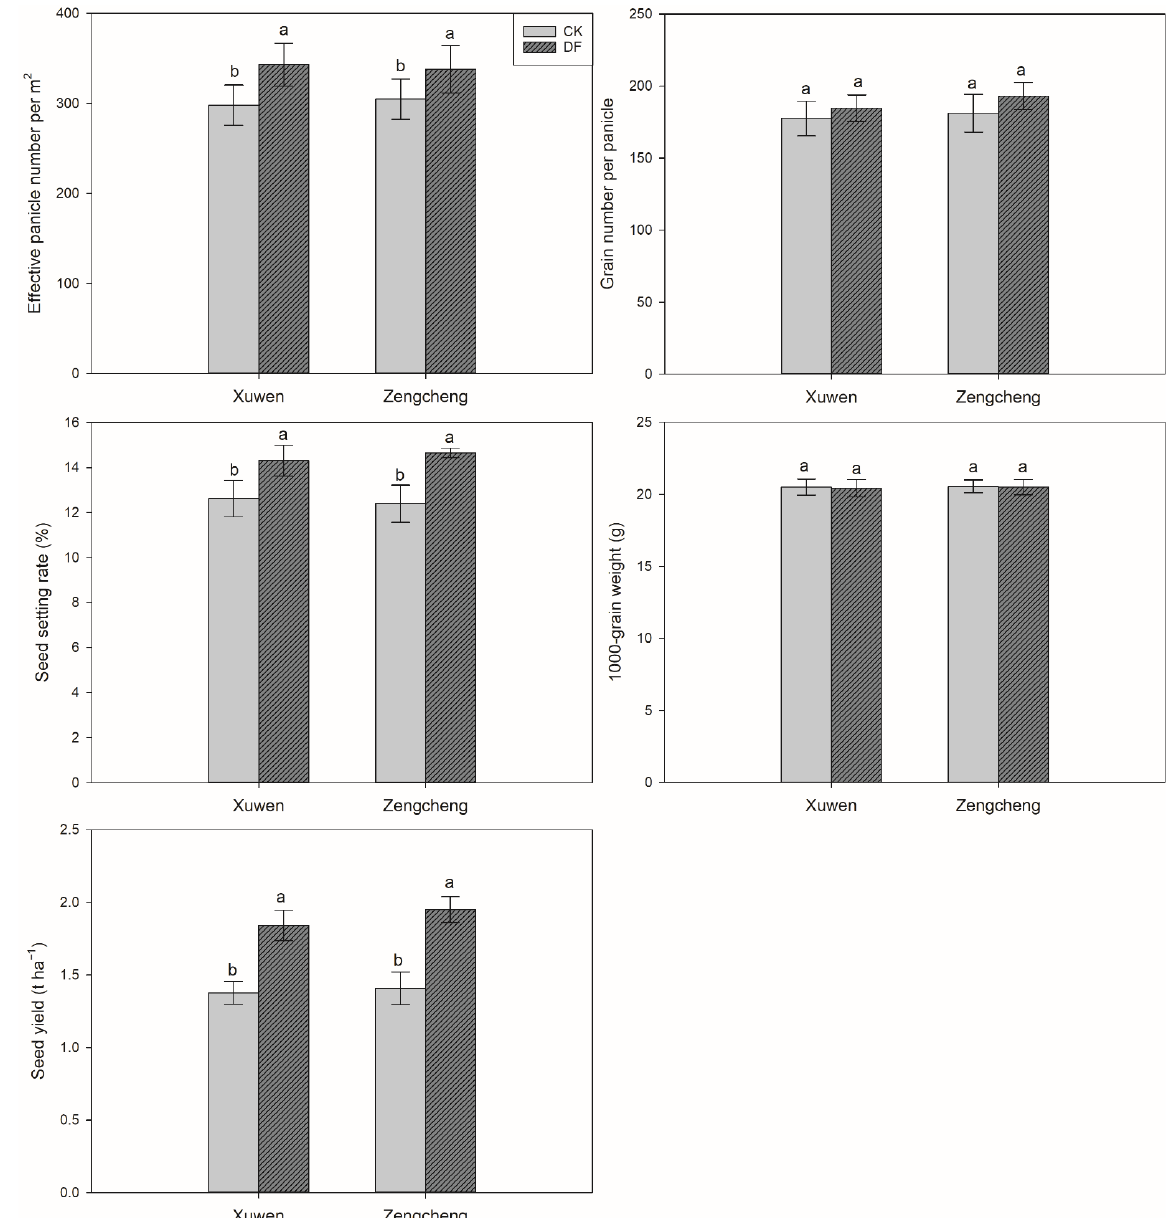
Figure 2. Effects of different fertilizer application methods on hybrid rice seed production. CK: conventional manual broadcasting of fertilizer; DF: deep placement of fertilizer. Seed yield was at 14% moisture. The different letters above the column indicate a difference at p < 0.05 by LSD tests. Error bars represent standard error.